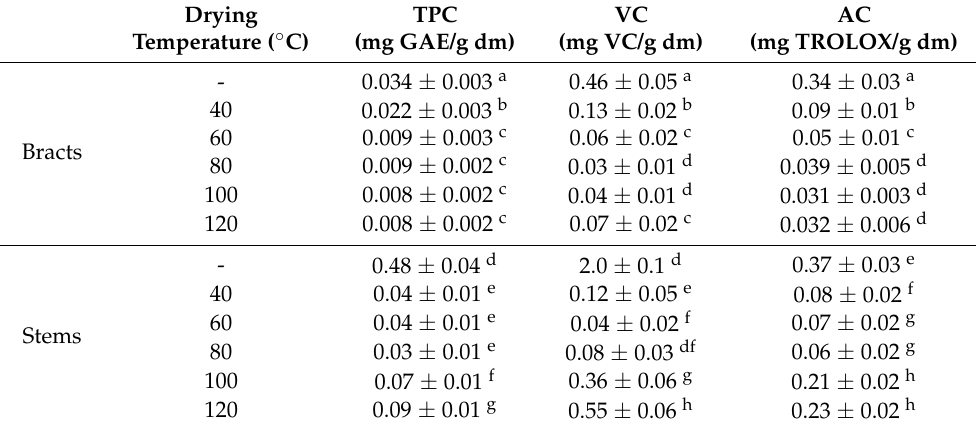
Table 2. Total Phenolic Content (TPC), vitamin C content (VC) and Antioxidant Capacity (AC) of artichoke bracts and stems, fresh and dried at different